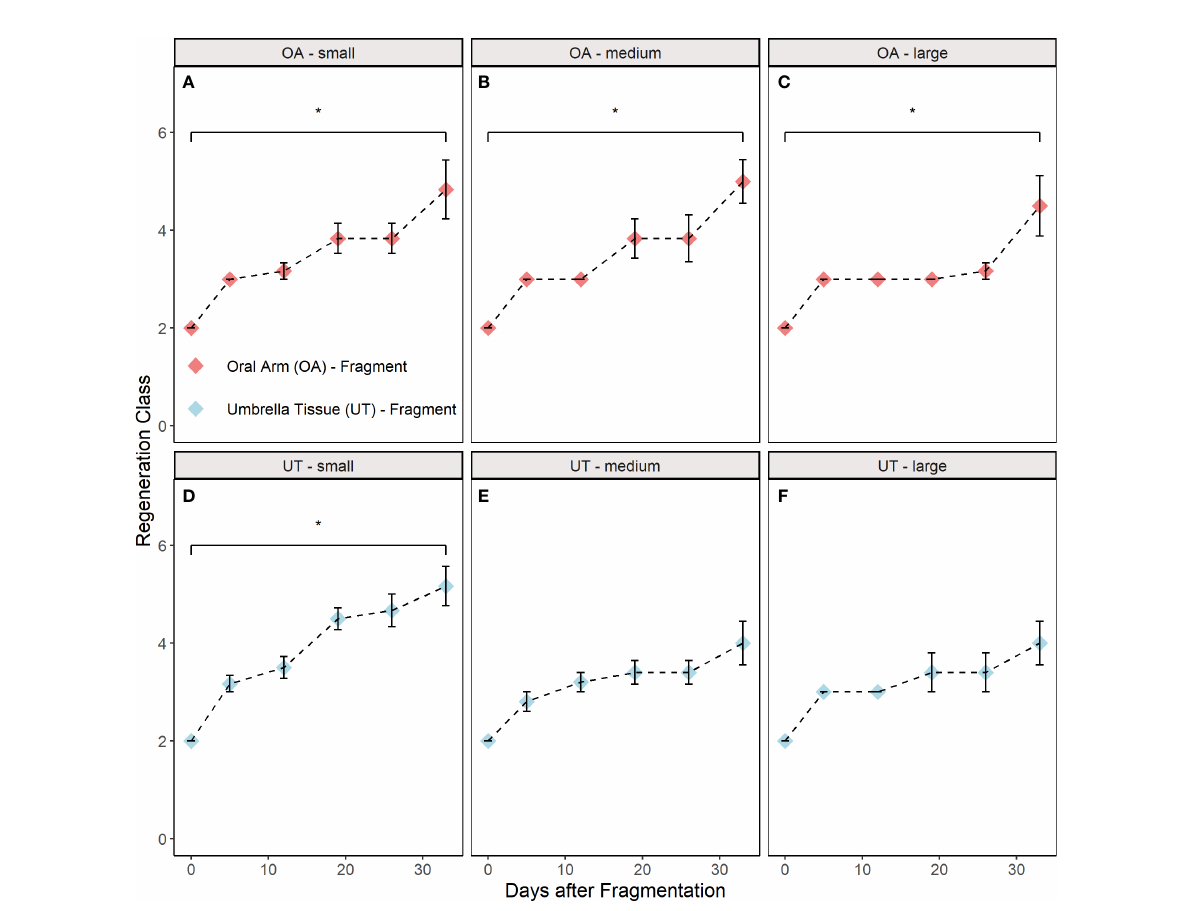
FIGURE 5 Regeneration classes during the experiment distributed into groups (A) oral arm (OA)-small, (B) OA-medium, (C) OA-large, (D) umbrella tissue (UT)-small, (E) UT-medium and (F) UT-large (n = 5 for the UT-medium and the UT-large group; n = 6 for the other groups). OA- and UT- fragments are indicated by red and blue colour, respectively. The control class is excluded since this group did not participate in regeneration. All data are shown as mean ± SE. Asterisks indicate signi fi cant differences between the initial and fi nal regeneration class (*p< 0.05). The respective criteria for the different regeneration classes are shown in Table